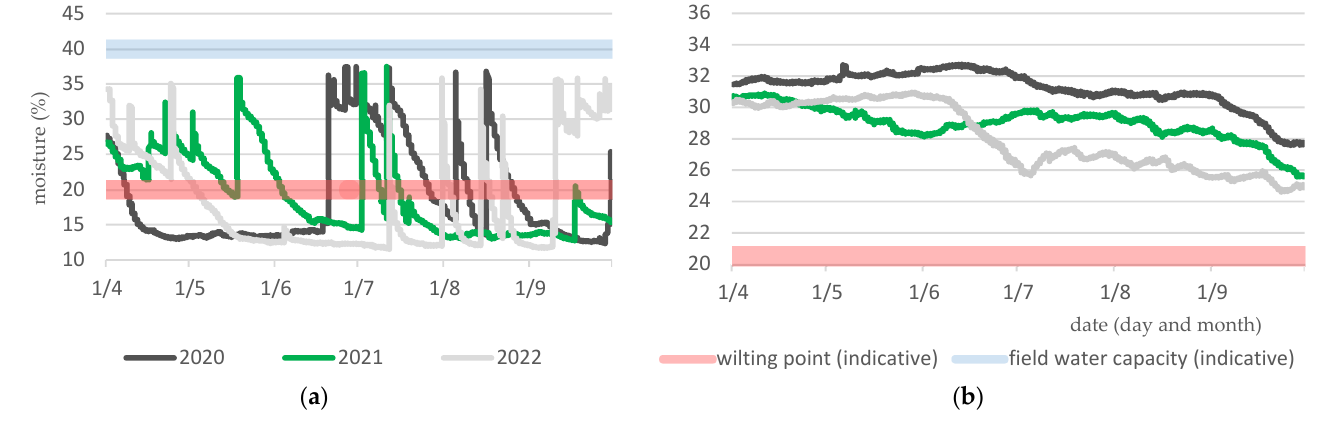
( b ) Figure 7. The time development of soil moisture (hour records) in full-production years at depths of 20 cm ( a ) and 50 cm ( b ). Data supplemented with the hydro-limit of fi eld water capacity and wilting point (40 and 20%, respectively, ranging from 35 to 46 and 17 to 23%, respectively in clay- loamy, heavy soils). Regarding the treatments, the strong in fl uence of the contrasting conditions was the least expressive under the HA treatment (Figure 6). An ameliorative dose of soil prepara- tion based on humic acids was used, which possibly triggered a hormonal e ff ect activated to support root growth, though this needs to be proven in more causality studies. Context